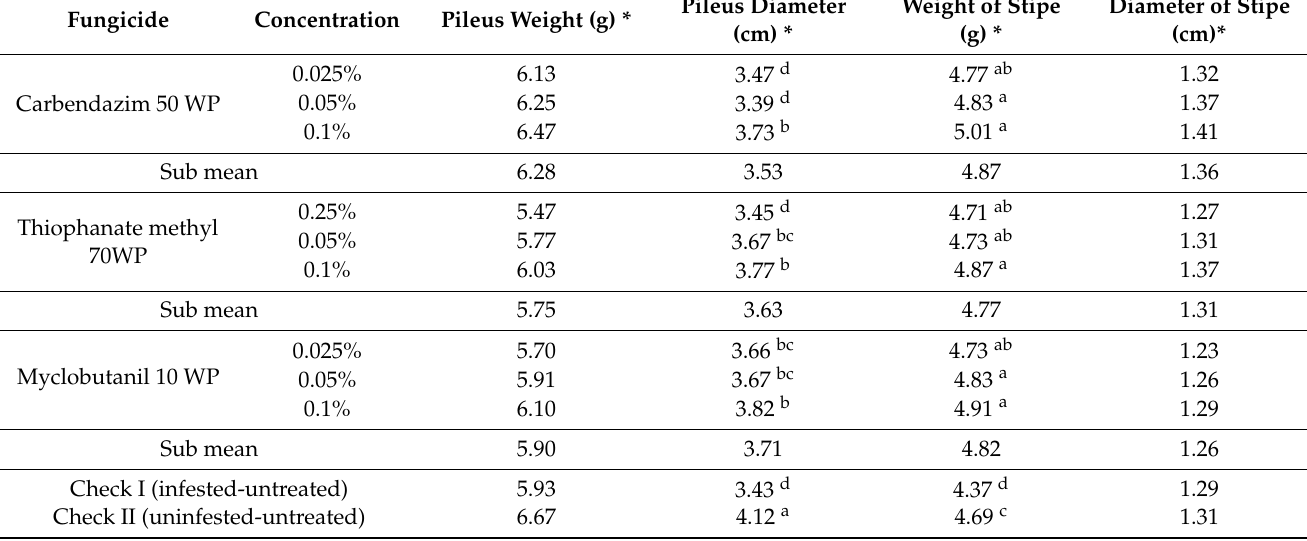
Table 11. Impact of systemic fungitoxicants on T. harzianum -infested casing pooled during spring 2017 and 2018 on quality parameters of A. bisporus